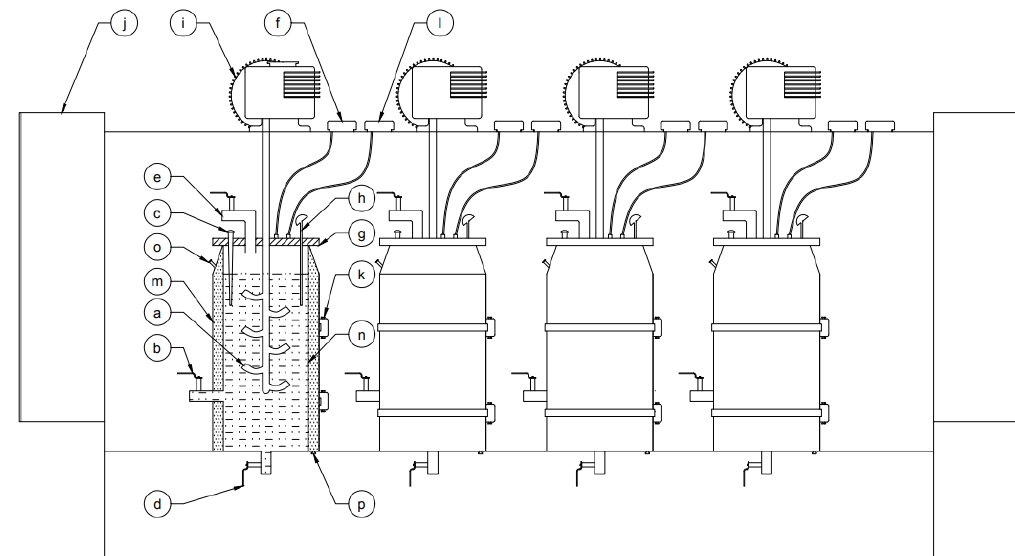
Figure 1. Semi-continuous anaerobic co-digestion pilot-scale plant. ( a ) Stirrer, ( b ) collection valve, ( c ) pH meter, ( d ) drainage valve, ( e ) milligas-counter, ( f ) acid supply pump, ( g ) closing lid, ( h ) temperature sensor, ( i ) servomotor, ( j ) control panel, ( k ) heating system, ( l ) base supply pump, ( m ) reactor, ( n ) separation chamber, ( o ) heating fluid inlet, ( p ) heating fluid outlet.